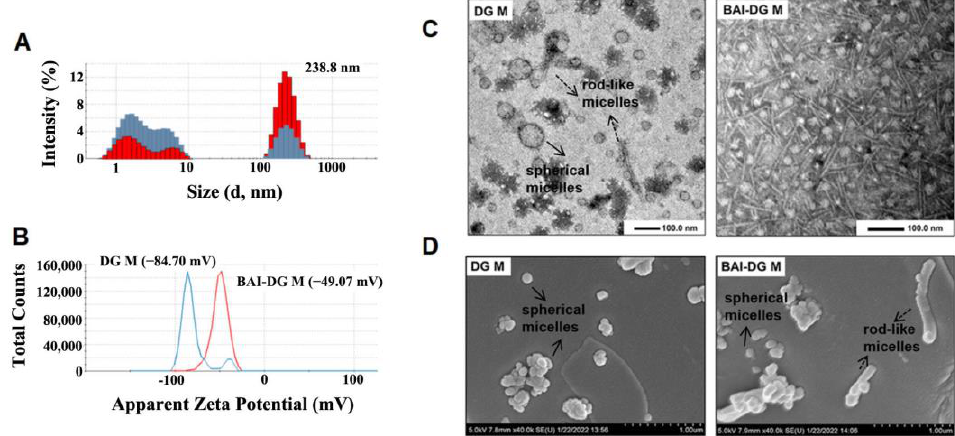
Figure 3. ( A , B ) Particle size distribution and zeta potential of the DG Ms (blue) and BAI-DG Ms (red) in water; ( C , D ) TEM and FESEM images of DG Ms and BAI-DG Ms (DG represents diammonium glycyrrhizinate, and BAI represents baicalin).